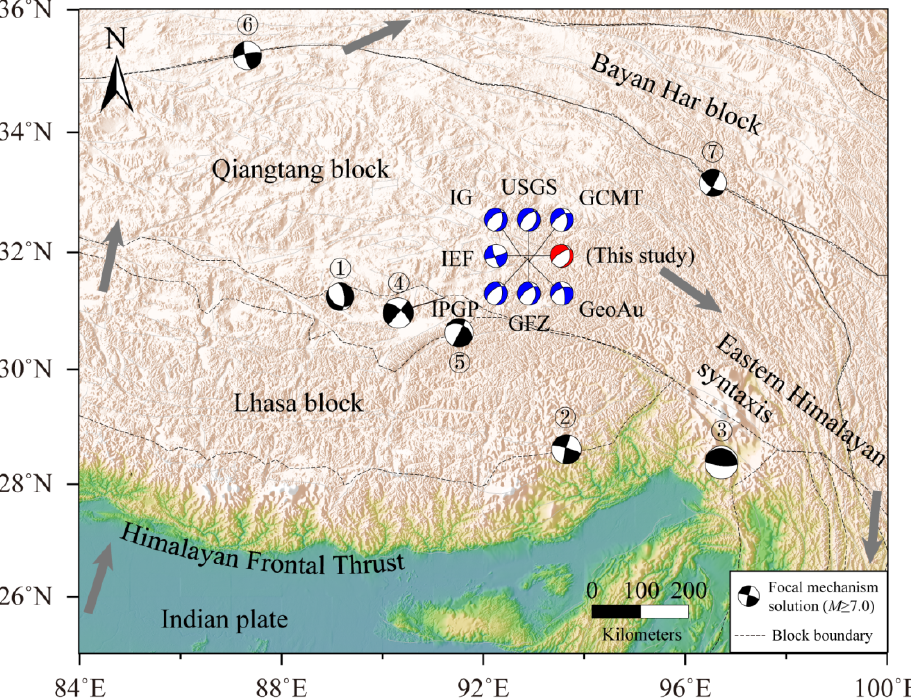
Figure 1. Regional tectonic setting and strong historical earthquakes. The blue and black beach balls represent the focal mechanism solutions of the Nakchu earthquake from different groups and the surrounding historical M ≥ 7.0 strong earthquakes, respectively. The gray arrow indicates the motion directions of the Indian plate and Tibetan plateau [12]. Table 1. Different focal mechanism solutions of the Nakchu earthquake.